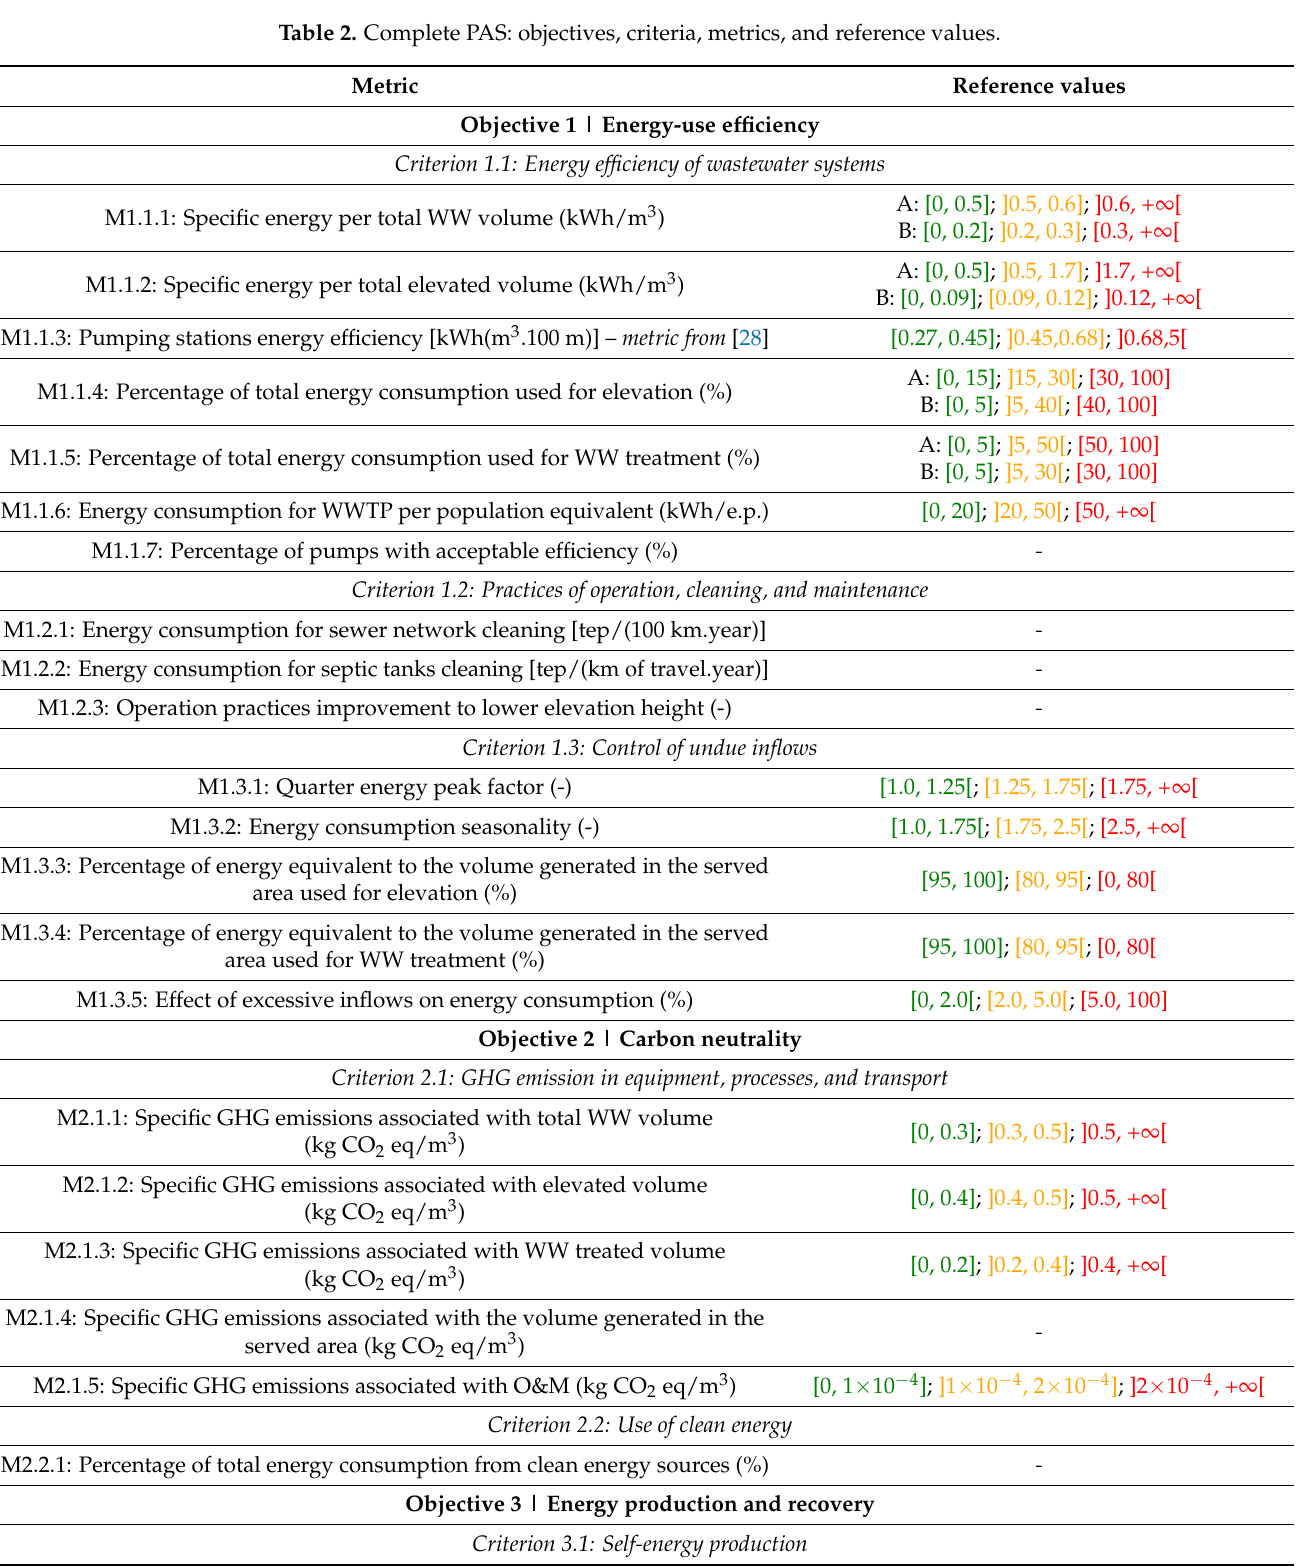
Table 2. Complete PAS: objectives, criteria, metrics, and reference